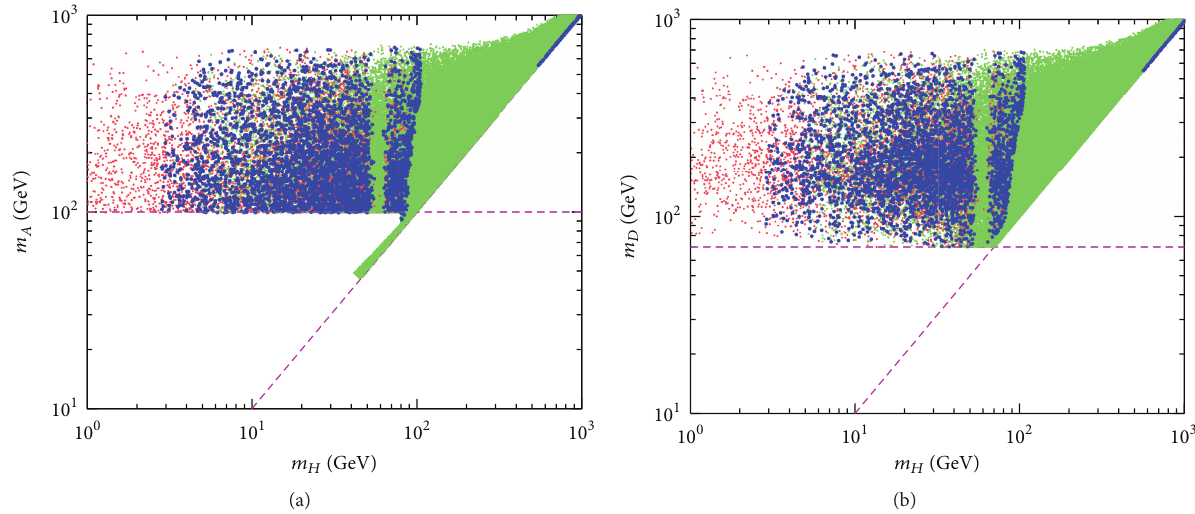
Figure 2: Inert Higgs masses 𝑚 𝐴 (a) and 𝑚 𝐷 (b) as a function of the DM candidate mass 𝑚 𝐻 , for the same random scan of IHDM parameter space. The horizontal dotted line is due to LEP constraints and the diagonal dotted line is due to the 𝑚 𝐻 -DM condition.